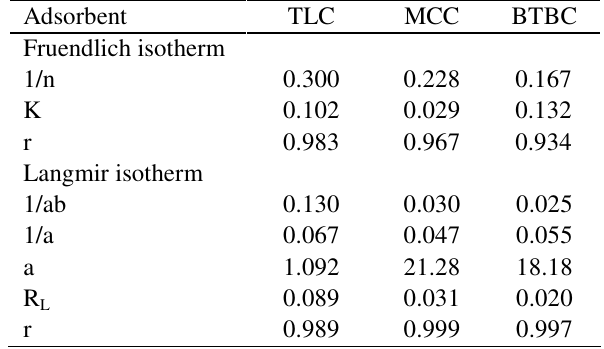
Table 2. Adsorption isotherm data estimated for the removal of dyes from waste